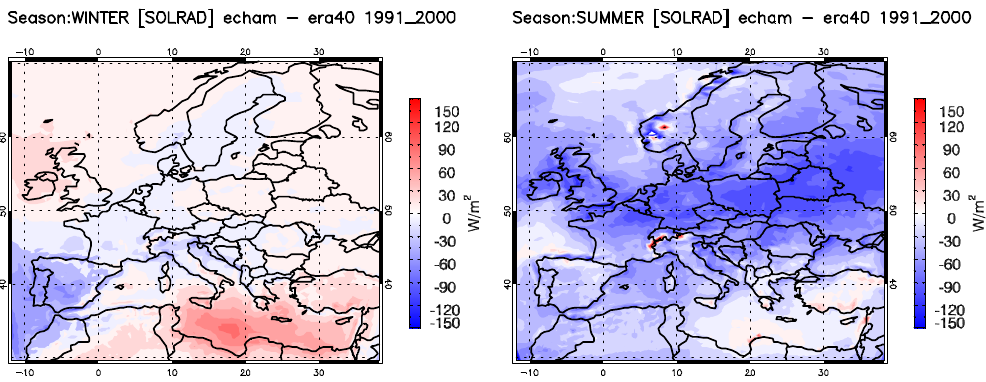
Fig. 5. Differences in simulated average incoming solar radiation fields between the ECHAM and ERA simulations for winter (left) and summer (right) representative of the 90s.